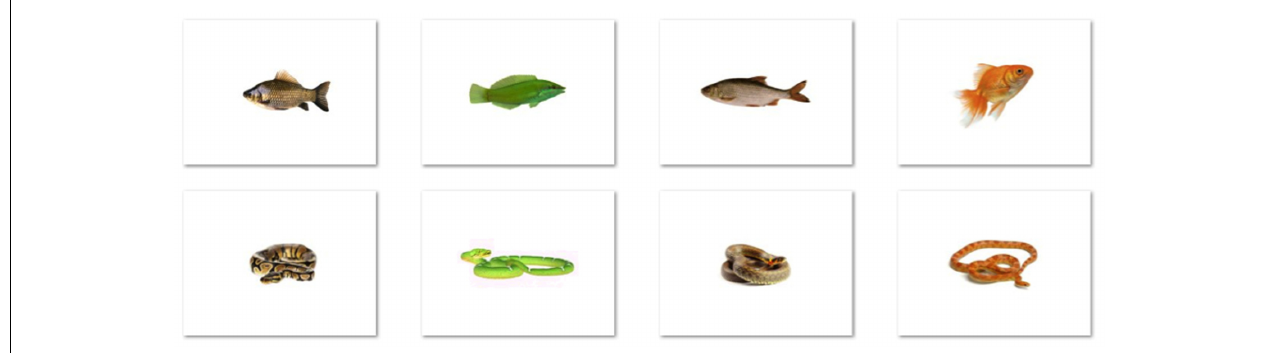
FIGURE 2 | Four pairs from the total of eight color-matched pairs of fish (Top) and snakes (Bottom) used in Studies 1 and 2. Each item from the snake category has a corresponding color-matched fish item.